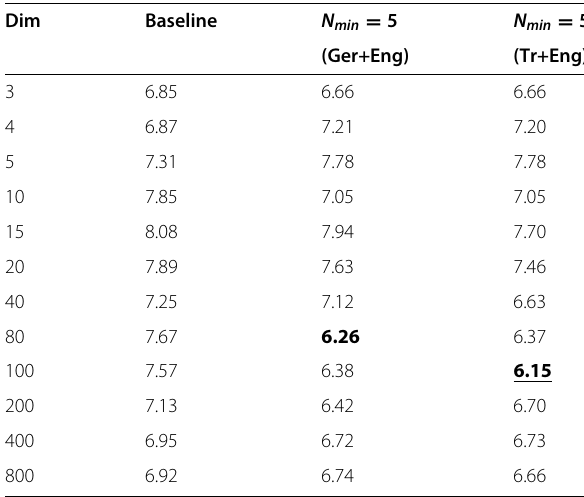
Table 6 Regression performance of the ml-MRMR method for the English task when the minimum occurrence threshold ( N min ) is set 5. In the underlined bold case, improvement is significant compared to the baseline system. Best result with the Tr+Eng also significantly outperformed the Gemaps feature set that had an RMSE of 6.72